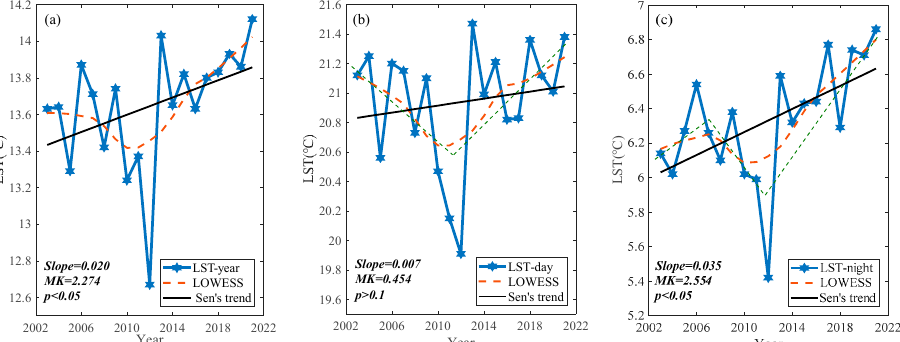
Figure 2. Average LST change trends from 2003 to 2021: ( a ) interannual; ( b ) day time and ( c ) night time. The green line is a piecewise fitting.